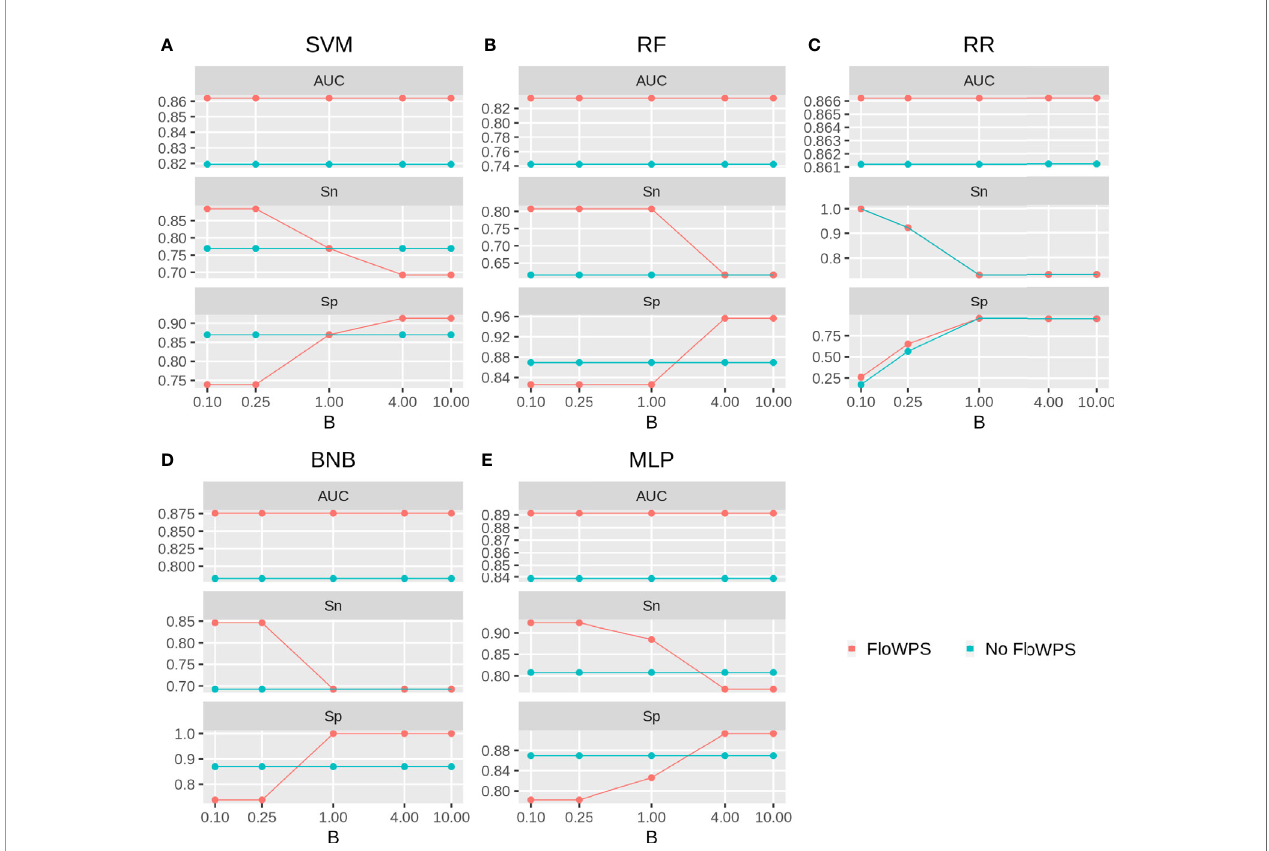
FIGURE 6 | Area under receiver-operator curve (AUC), sensitivity (Sn) and Speci fi city (Sp) for fi ve ML methods (A) linear SVM, (B) RF, (C) RR, (D) BNB, (E) MLP during classi fi cation of response to VCD treatment of 47 MM patients (VCD cohort). Parameter B is false positive vs. false negative balance